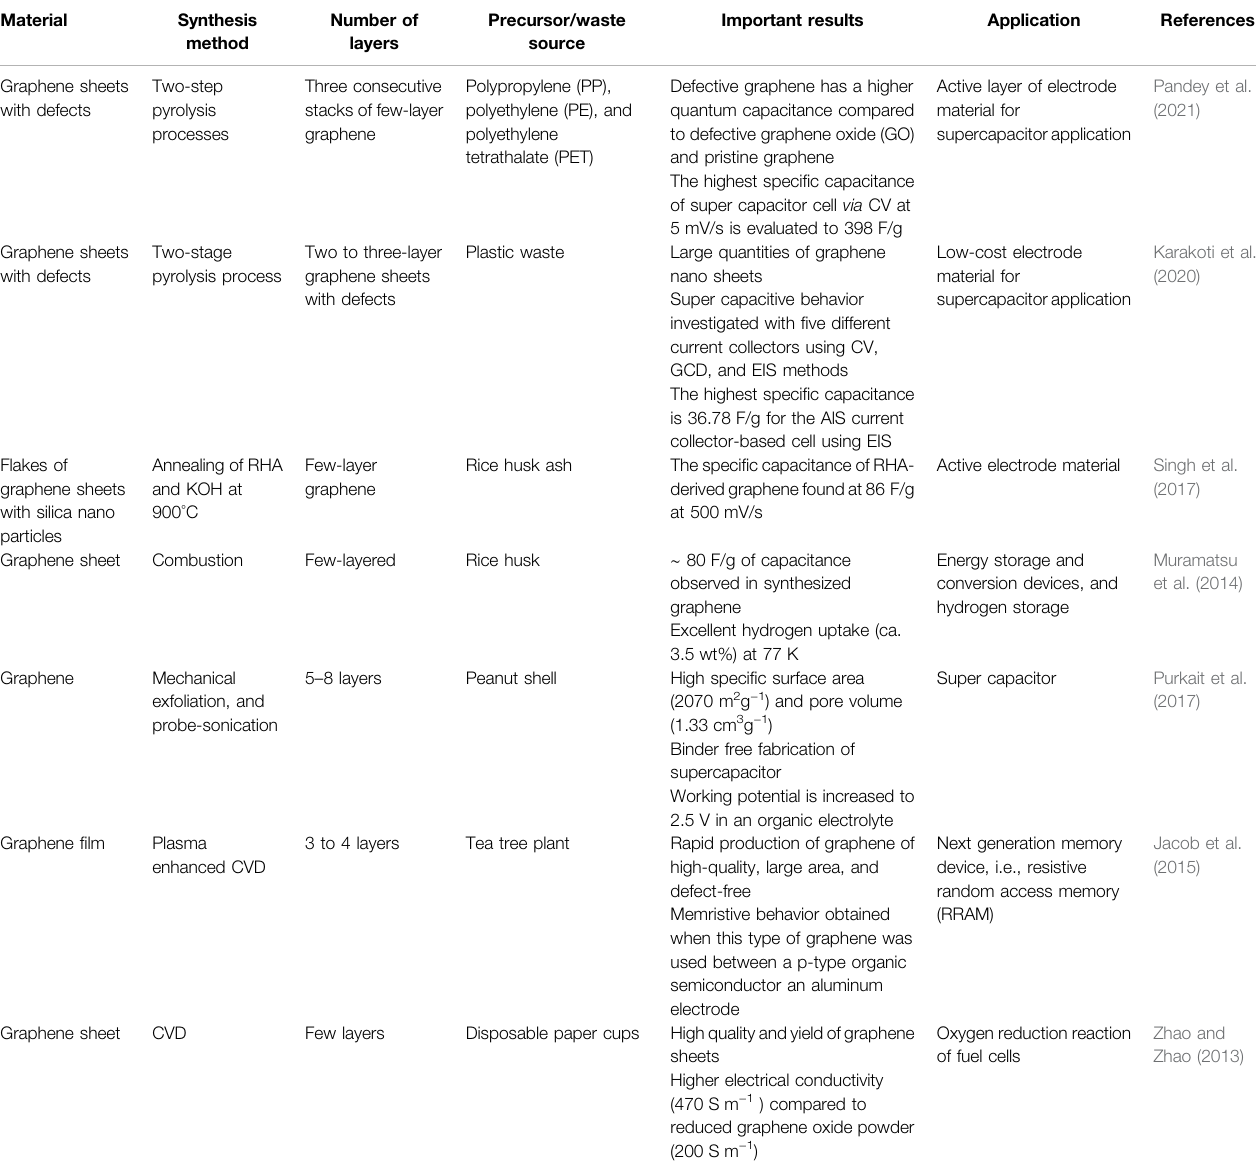
TABLE 2 | Application of biogenically synthesized